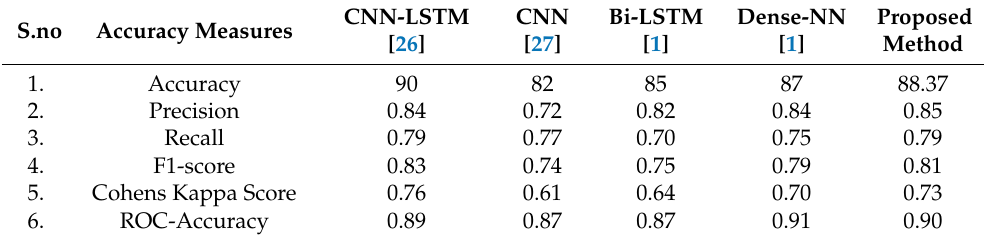
Table 9. Comparative study of various deep learning algorithms for classification of siabetes by dividing dataset into testing and training [59,60].